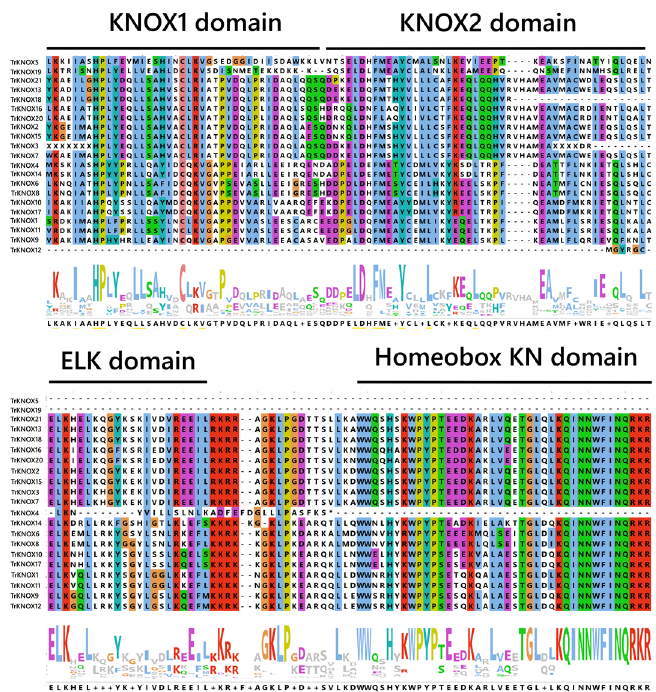
Figure 2. Sequence alignment and logo of KNOX domain from Trifolium repens. KNOX1 domain, KNOX2 domain, ELK domain, and Homeobox KN domain have been marked.